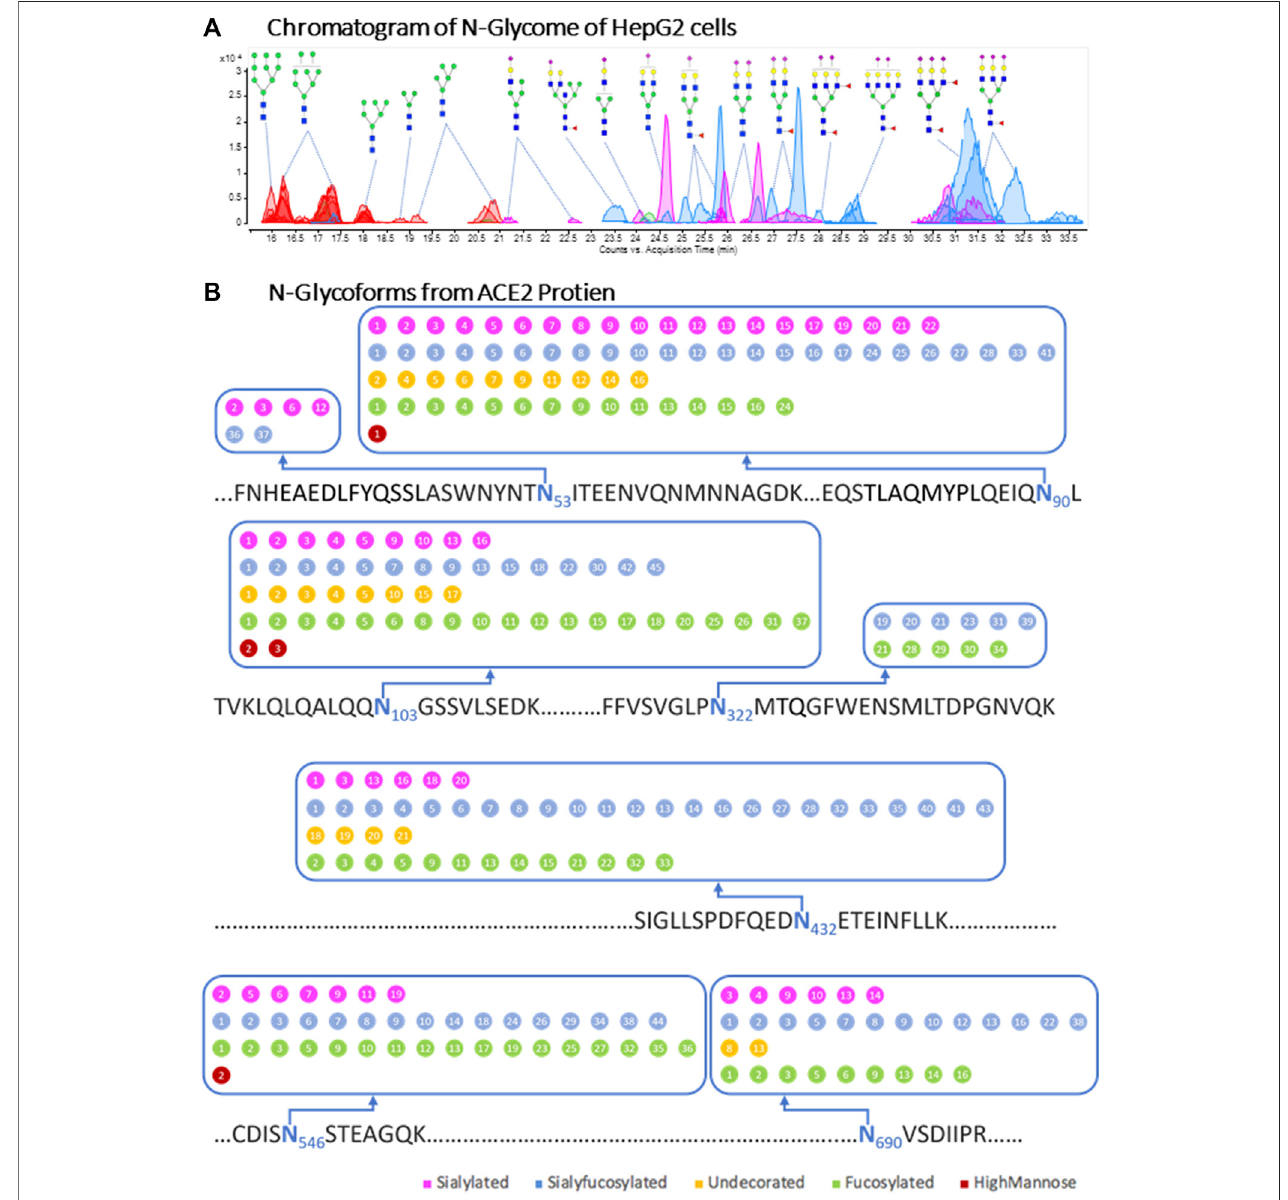
FIGURE3| Cellmembrane N-glycome and site-speci fi coccupancy ofACE2 receptor inHepG2 cells. (A) Individual N-glycan species ofHepG2 hostcells. LC-MS peaks were color coded to assign glycan subtype. Abundant peaks are annotated with putative structures. Symbol nomenclature is used for representing glycan structures (https://www.ncbi.nlm.nih.gov/glycans/snfg.html). (B) Site-speci fi c occupancy of ACE2 receptor in HepG2 cells. The N-glycoforms from ACE2 protien extracted from HepG2 cells are distributed on seven glycosites. The labeled numbers inside dots denote identi fi ed individual glycan and the details were shown in Supplementary Table S2